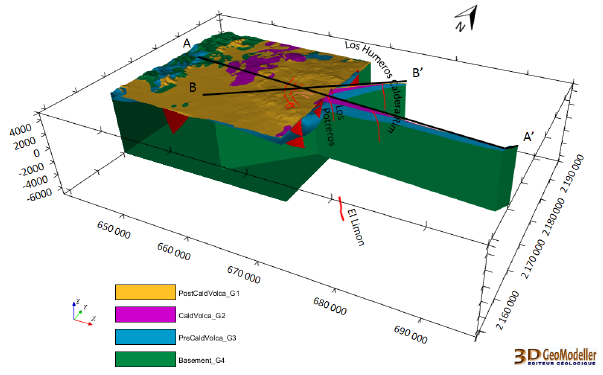
Figure 10. The Los Humeros regional geological model includ- ing the fault model (see 3DLHRegionalFaultModel) and the four geological groups listed at bottom left. AA’: Carrasco-Núñez et al. (2017a) cross-section, BB’: Norini et al. (2015) cross-section (see Fig. 8). Coordinate system is WGS84/UTM zone 14N.